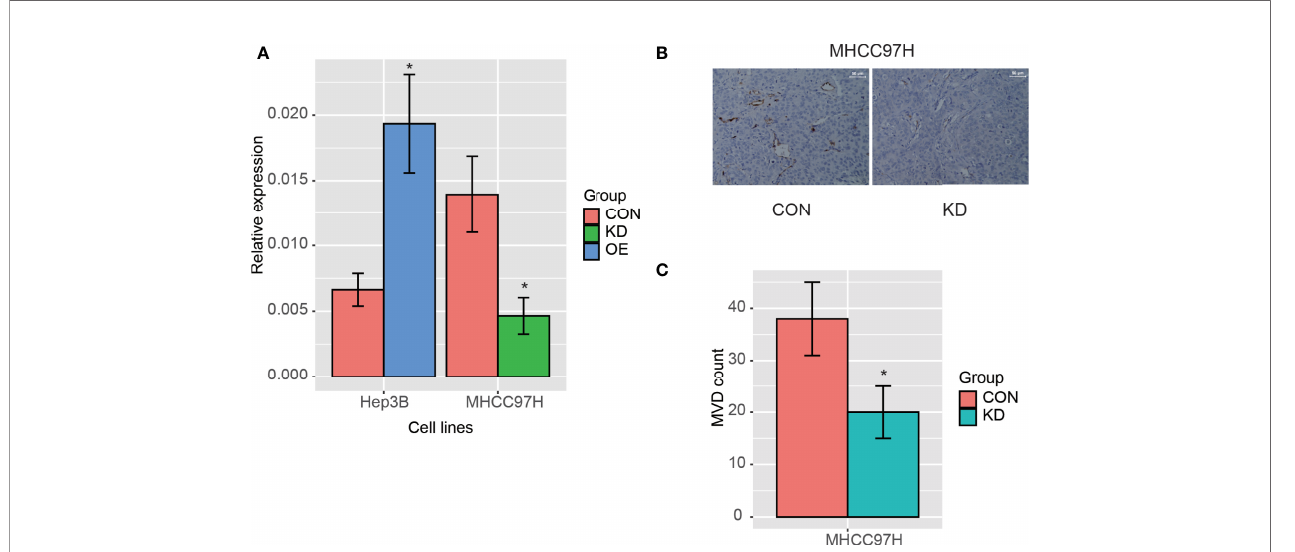
FIGURE 7 | The PLCB1 expression in HCC cell lines. (A) The RNA expression of PLCB1 by the knockdown and overexpression of PLCB1 mRNA. (B) The microvessel density (MVD) in HCC tissue with PLCB1 knockdown and the control. (C) The MVD count in HCC tissue with PLCB1 knockdown and the control. *: P- value <